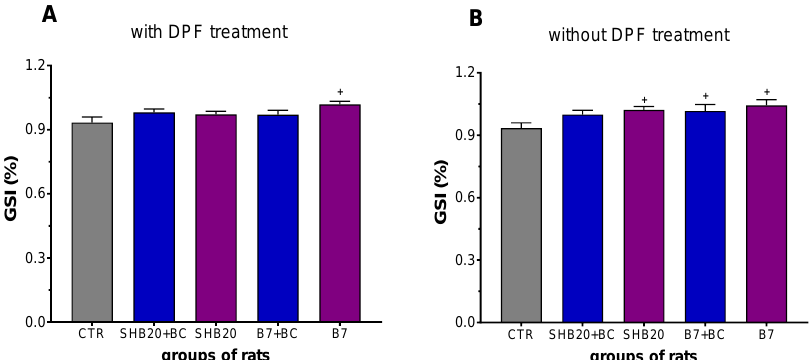
Figure 3. Gonadosomatic index (GSI) of testes of rats exposed to DEE from B7 or SHB20 biofuels without ( A ) or with ( B ) DPF-treatment and with or without blackcurrant pomace supplementation (BC) for 28 days. CTR—control group; B7—1st generation biofuel; SHB20—2nd generation biofuel; BC—blackcurrant pomace; DPF—diesel particulate filter; + denotes statistically important difference vs. CTR group, p < 0.05. Data are expressed as mean ± SEM.